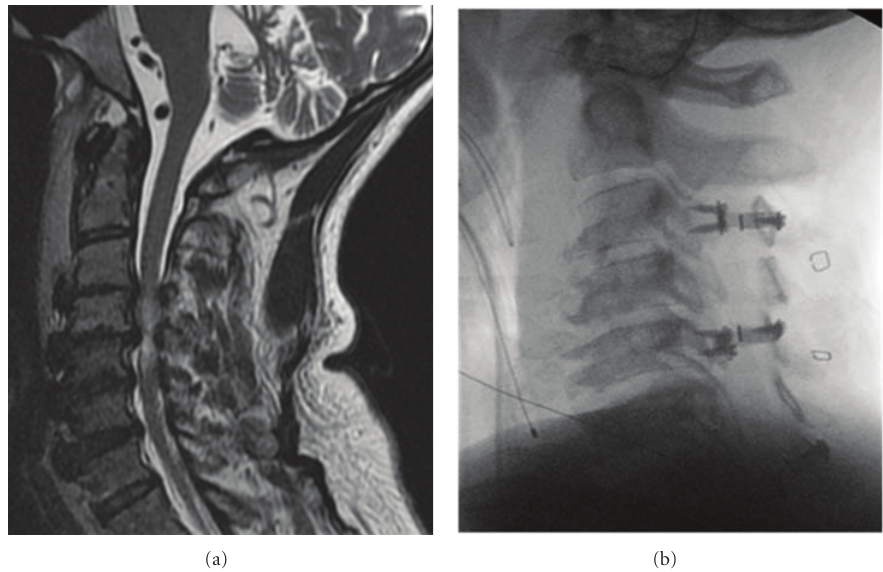
Figure 4: (a) Sagittal MRI of a patient with multilevel stenosis and preserved lordosis. (b) Lateral radiograph of same patient after canal- expanding